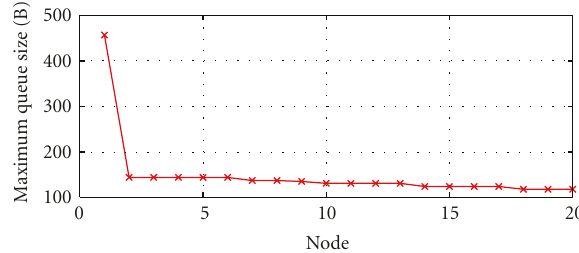
Figure 13: Maximum queue size for each node in 20 nodes